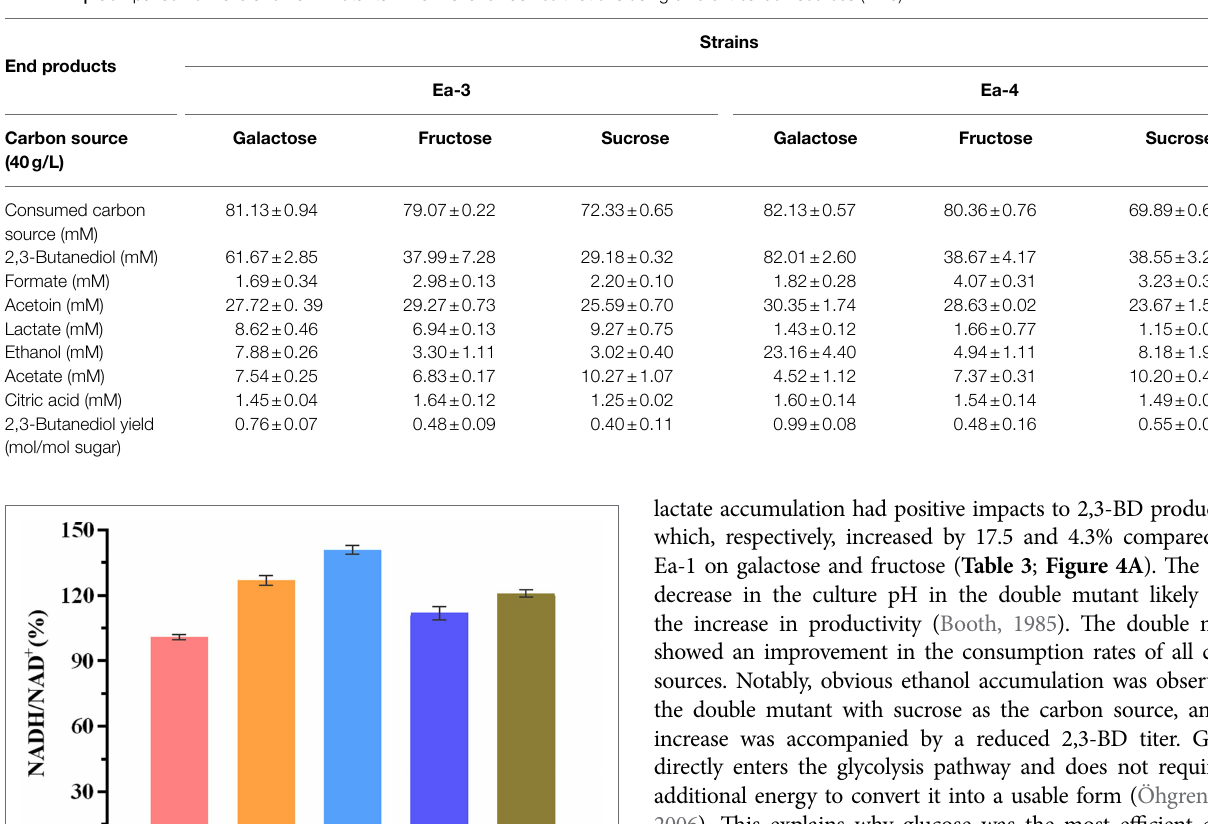
FIGURE 4 | Comparison of 2,3-BD yields from different carbon sources for the wild-type strain and the mutants. (A) 2,3-BD yield of IAM1183, Ea-1, and Ea-2. (B) 2,3-BD yield of IAM1183, Ea-3, and Ea-4 ( n =3). The data shown in Tables 2 and 3 were used for the calculations. TABLE 4 | Comparison of Ea-3 and Ea-4 mutants in 20-h shake-flask cultivations using different carbon sources ( n = 3).